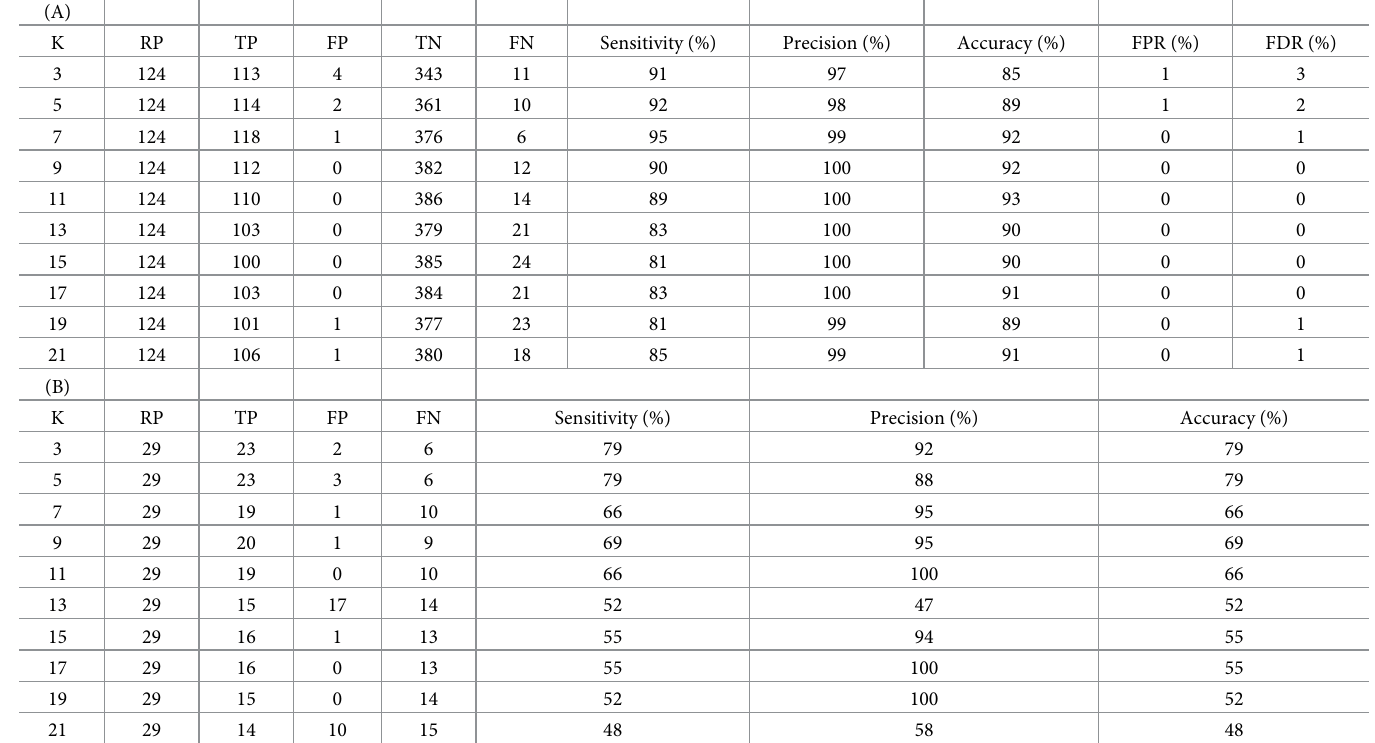
Table 1. The number of the condition positive (RP), condition negative (RN), true positive (TP), true negative (TN), false positive (FP), and false negative (FN), as well as sensitivity, accuracy, precision, false positive rate (FPR) and false discovery rate (FDR), calculated for the controlled environment (A) and natural environment trials (B).